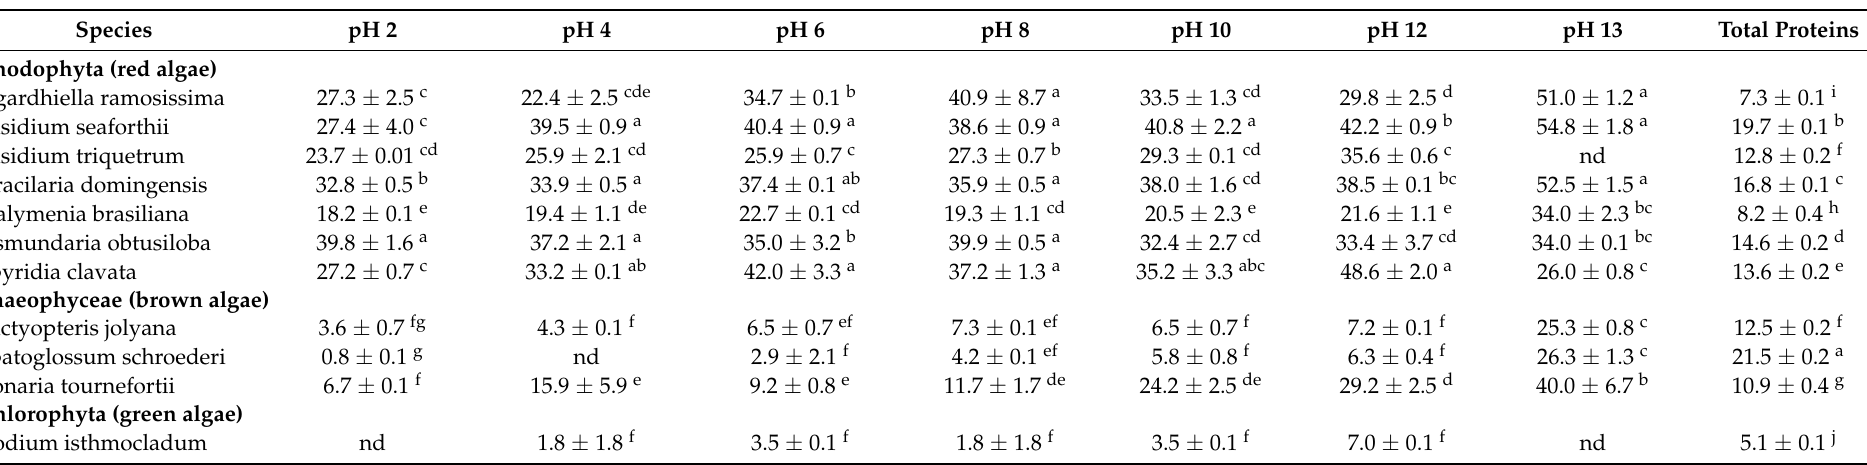
Table 5. Solubility of total proteins from beach-cast macroalgae (%) at different pH levels. Values represent the average of three replicates (mean ± SD), and letters indicate statistical significance ( p < 0.05). nd = not